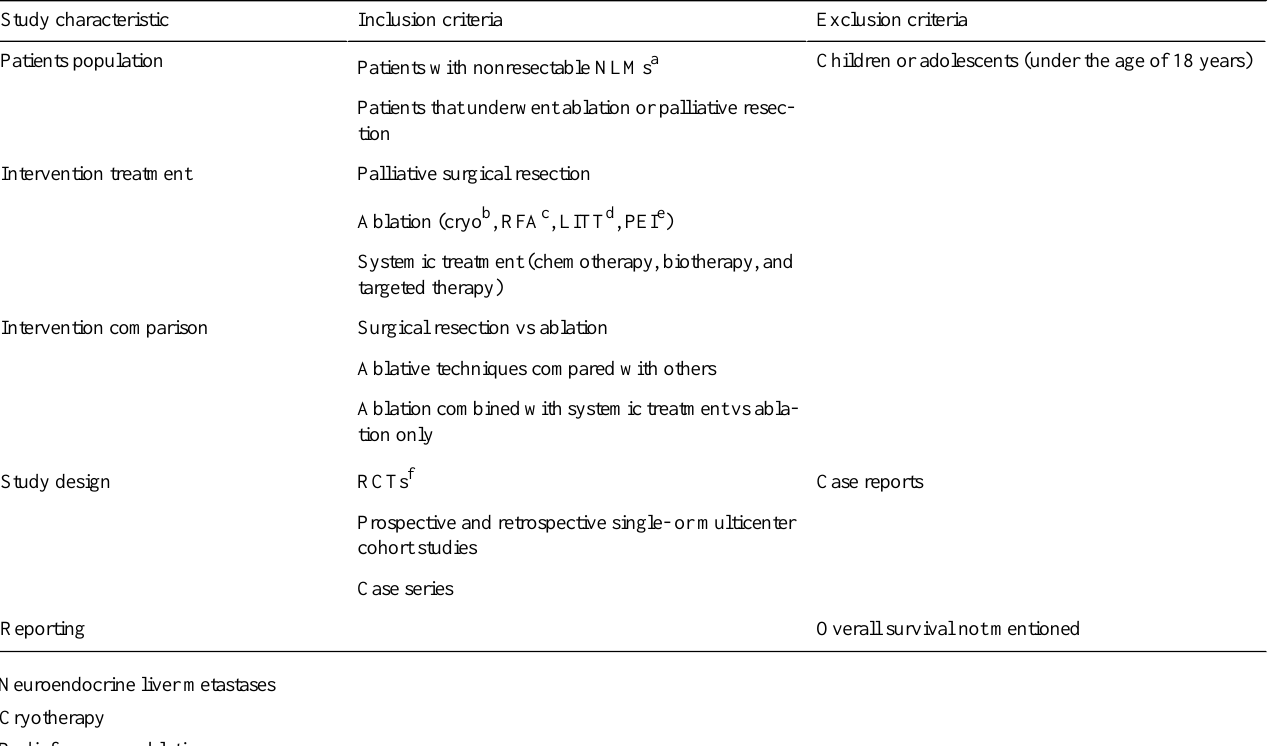
Table 1. Eligibility criteria for review 1: when should locally ablative techniques be used in patients with unresectable neuroendocrine liver metastases?